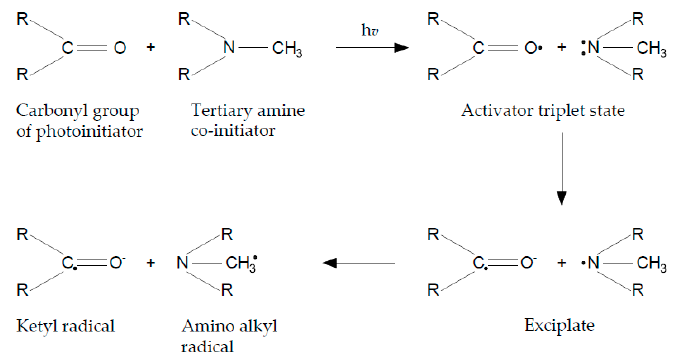
Figure 2. Photoinitiation by hydrogen abstraction (Type-2 photoinitiator).